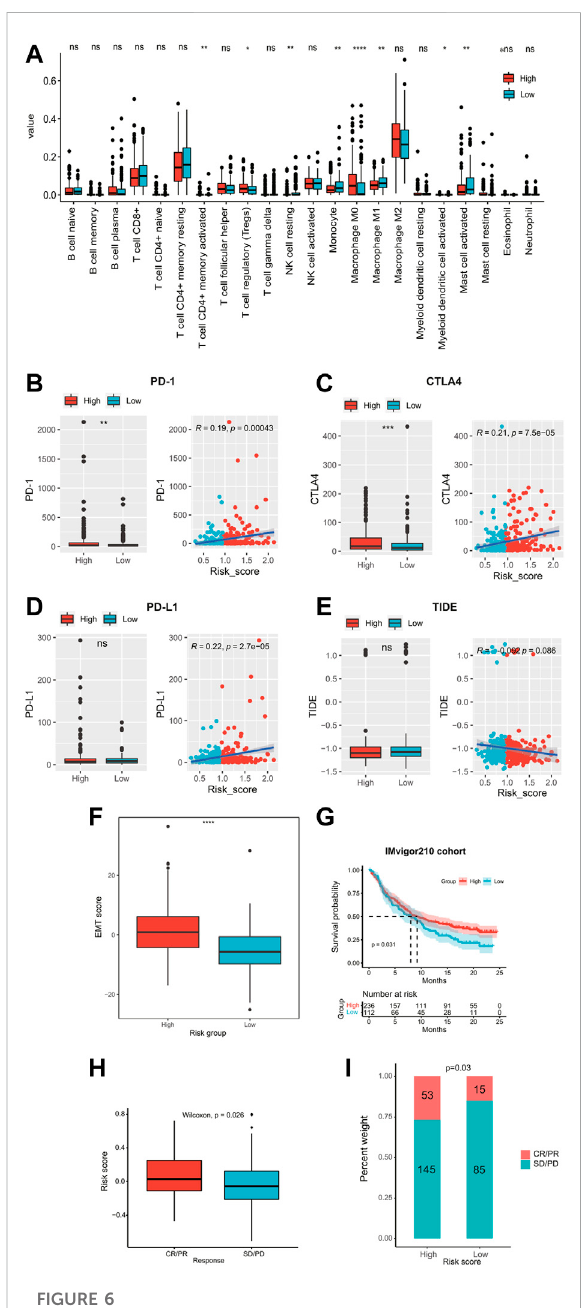
FIGURE 6 Immune landscape, immune checkpoint pro fi le,